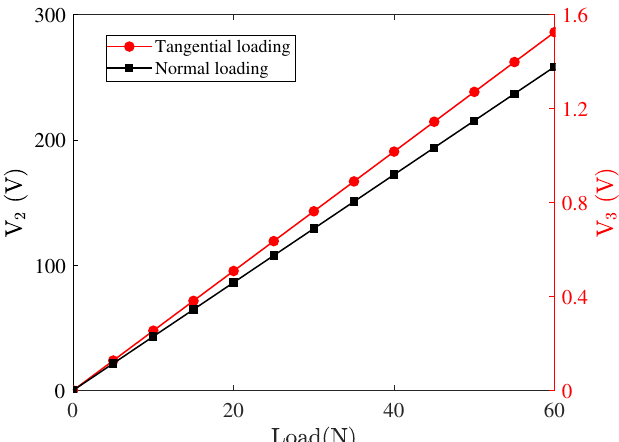
Figure 11. The force–voltage relationship for the designed